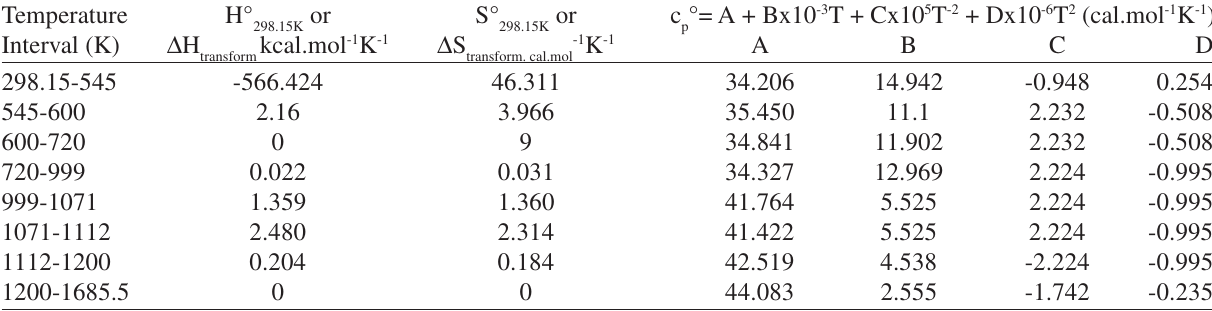
Table 1. Thermodynamic data of the species Ce a function of temperature, enthalpies and entropies at 298.15K , as well as enthalpies and entropies of phase transformation.